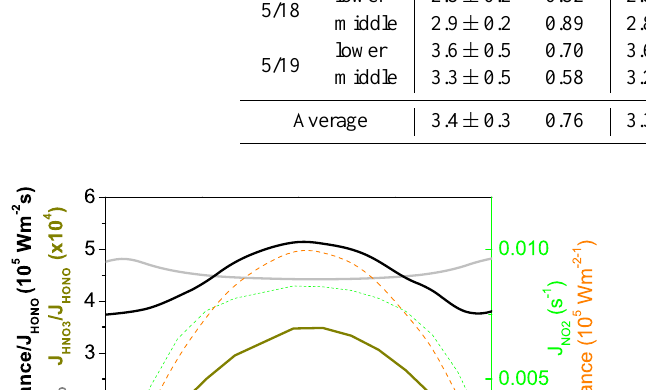
(Table 1). For example, R 2 improved from 0.72 and 0.76 on the lower and middle light path, respectively, to 0.86 and 0.90 on 21 April. The correlations increased on the other days as well, with the best correlation between P norm and visible solar irradiance of 0.96 found on 18 May in the mid- dle height interval. A visual comparison of Fig. 8a and b reveals that the improved correlation stems from a better lin- earity between the P norm and solar irradiance. All four